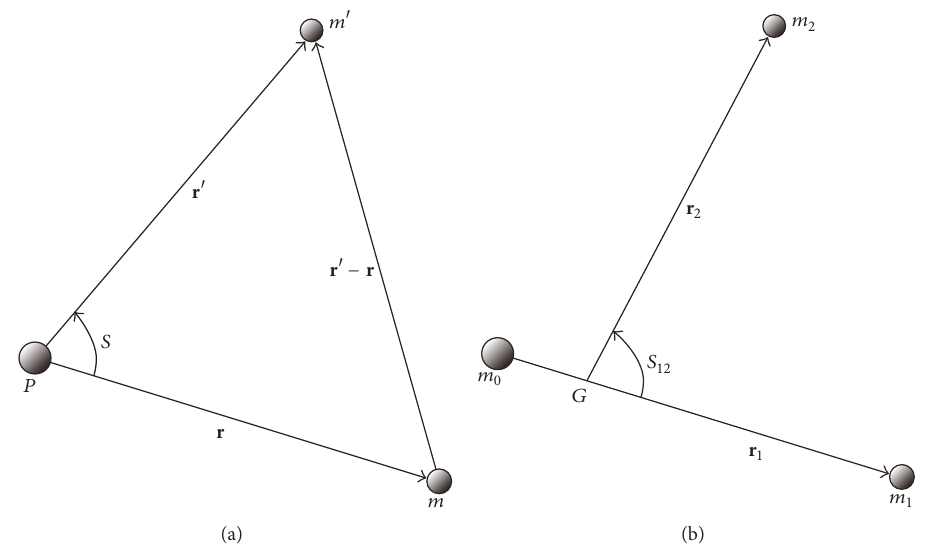
Figure 1: A schematic illustration of the three-body configuration considered here in two kinds of coordinate. (a) Relative coordinate. Both the vectors r and r 󸀠 originates from the central mass denoted as 𝑃 . (b) Jacobi coordinate. The vector r 1 is originated from the primary mass ) , and the vector r (𝑚 0 2 is originated from the barycenter of the primary mass and the secondary mass